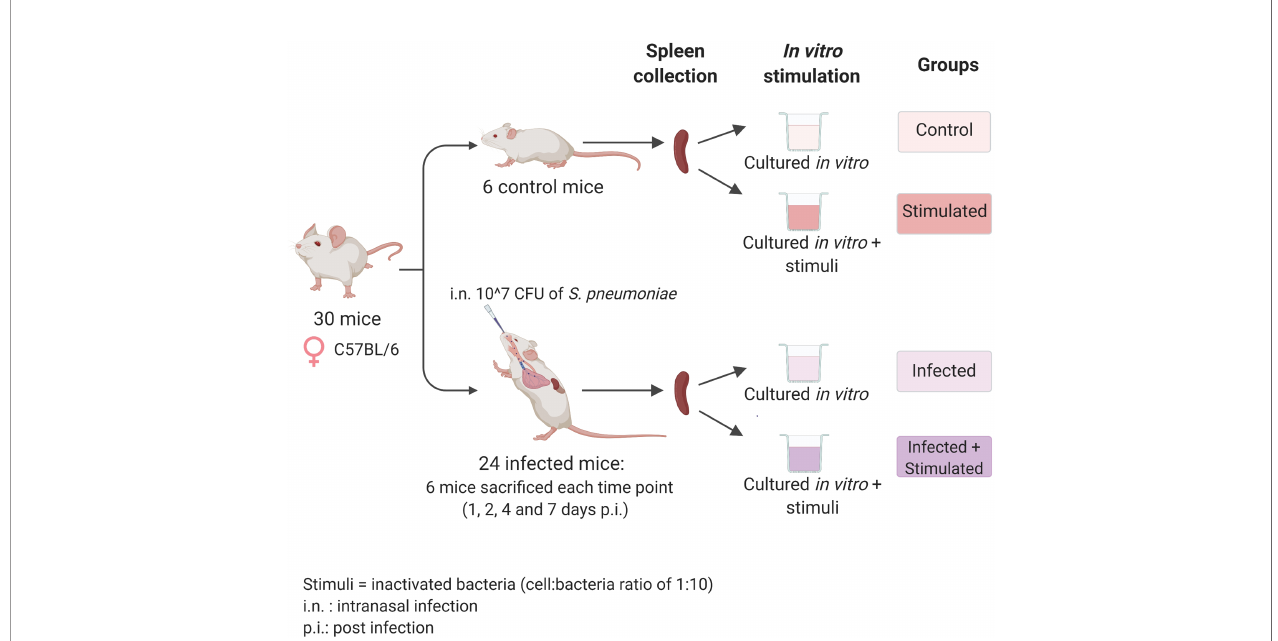
FIGURE 1 | Experimental design. Seven-weeks old C57BL/6 female mice were infected intranasally with a dose of 10^7 CFU/mouse of pneumococcal serotype 4, TIGR4 strain. After 1, 2, 4, and 7 days post-infection each group of mice (n=6) was euthanized and their spleens were collected for the isolation of splenocytes. Splenocytes from each single mouse were stimulated with formalin-inactivated TIGR4 (cell:bacteria 1:10), or maintained in cRPMI medium alone. The incubation was performed at 37°C in 5% CO 2 in a period of 6 hours for samples used in the RNA-sequencing experiment or 72 hours for samples used in the Bio-Plex Multiplex immunoassay. Non-infected mice were euthanized at day 0, splenocytes were collected and maintained in the same in vitro conditions of the unstimulated group and used as controls. Created with